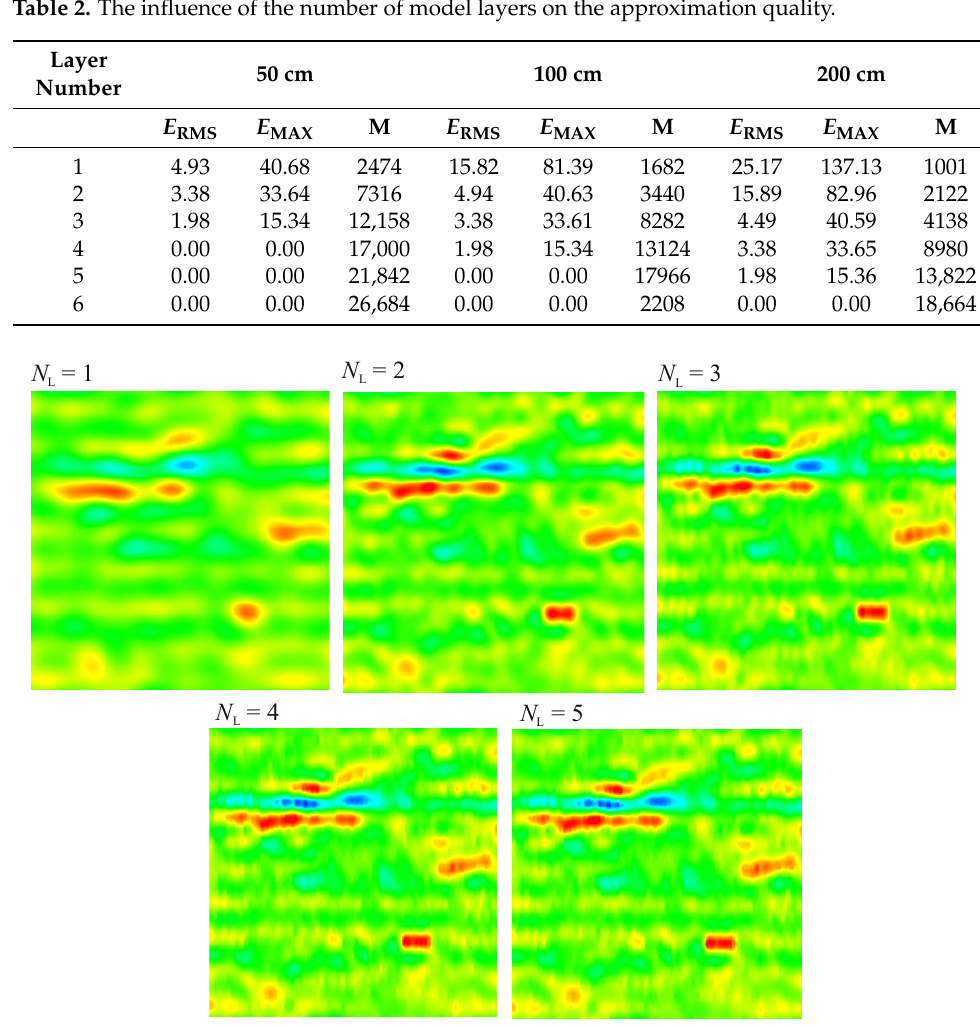
Figure 6. C-scans for different numbers of model layers.